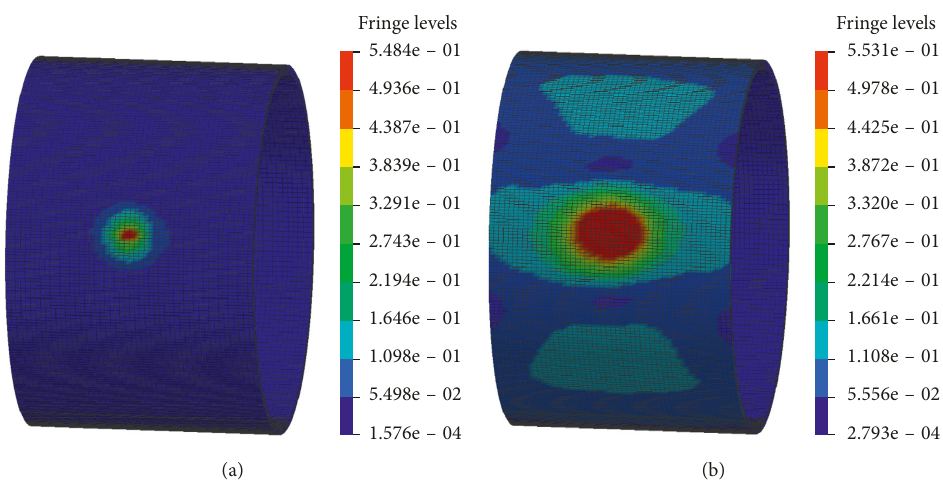
Figure 22: Stress nephograms of impact A within 10m. (a) 0.55s nephogram. (b) 0.58s nephogram.